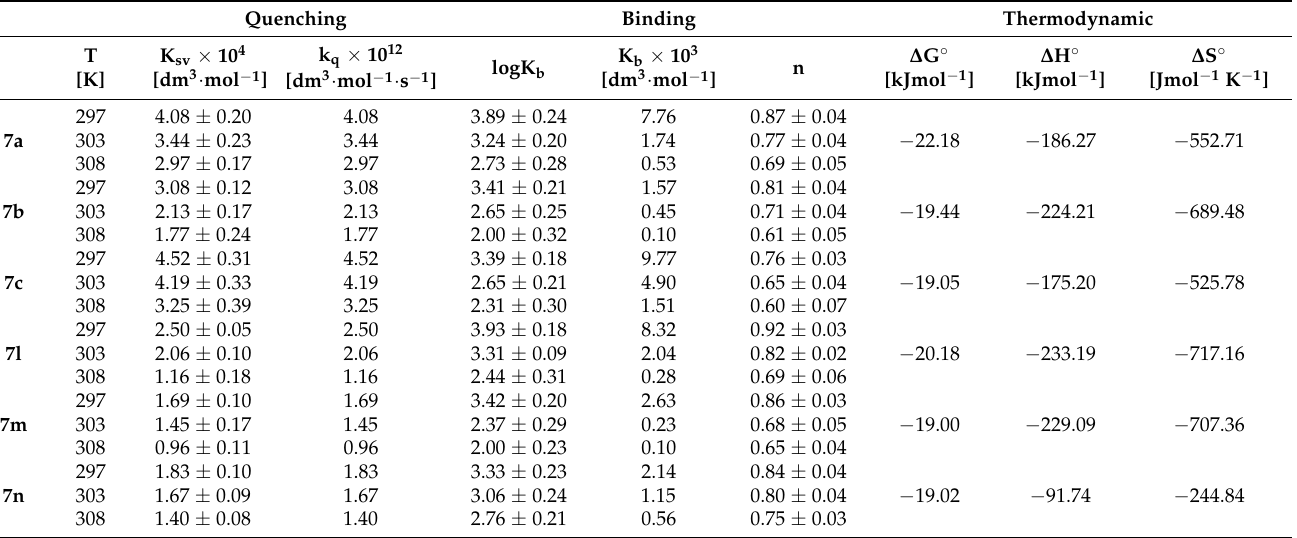
Table 9. The Stern–Volmer constant K sv , quenching rate constant k q , binding constants K b , number of binding sites n, and thermodynamic parameters for the interaction of alpha-1-acid glycoprotein (AAG) with the compounds at different